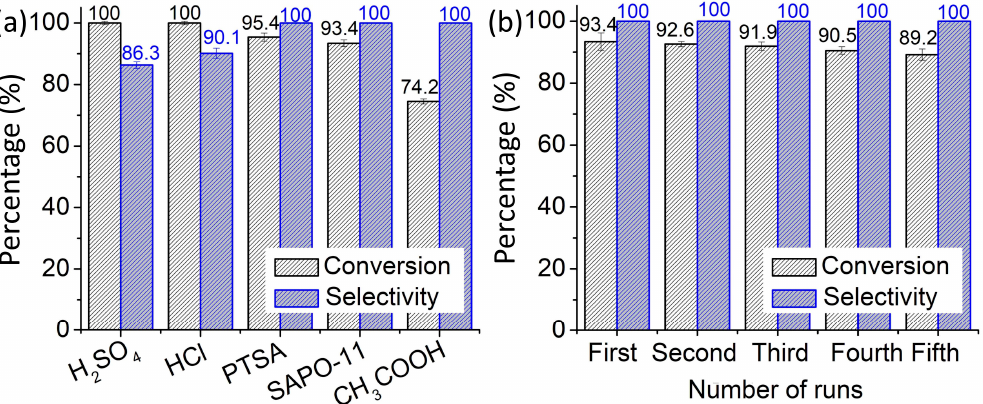
12 of 18 Figure 10. ( A ) Conversion of levulinic acid via esterification enhanced by SAPO-11 (E-3) catalyst at ( a ) 150 °C, ( b ) 160 °C, ( c ) 170 °C and ( d ) 180 °C under conductive instant heating using reaction conditions: m SAPO-11 = 0.100 g, levulinic acid:ethanol ratio = 1:11, and ( B ) effect of catalyst loading on the conversion of levulinic acid using reaction conditions: temperature = 180 °C, time = 30 min, le- vulinic acid:ethanol ratio = 1:11. The esterification reaction was also investigated at various temperatures (150 ‒ 180 °C) from 0 to 60 min. The reaction conversion is enhanced by increasing the heating tempera- ture, as shown in Figure 10A. This is due to the fact that when more energy is provided to the system, the reaction rate increases, as stated by the Arrhenius equation [55]. For in- stance, at 30 min of reaction, 82.6% of conversion is recorded at 150 °C, and this increases to 87.0% (160 °C) and 90.6% (170 °C) before reaching 93.4% at 180 °C (Figure 10A(a–d)). Based on the reaction study, the optimum reaction time and temperature are 30 min of heating at 180 °C, because the conversion rate nearly plateaus after 30 min. The effect of catalyst amount was also studied at 180 °C for 30 min with a molar ratio of 1:11 (levulinic acid:ethanol) using 0–0.125 g of SAPO-11. Without catalyst, the conver- sion rate is merely 6.6%, and the levulinic acid conversion rate rises significantly to 52.7% when 0.025 g catalyst is added (Figure 10B). The conversion rate keeps increasing to 93.4% with the catalyst load increased to 0.100 g. Such a phenomenon can be explained by the high availability of Brønsted acid sites when more solid acid catalyst is added, resulting in a high reaction conversion. However, the levulinic acid conversion slightly decreases when the catalyst loading is further increased to 0.125 g (91.7%), which may be due to the excessive catalyst loading causing inefficient stirring [56]. Furthermore, the water mole- cules produced during the esterification reaction can also deactivate the SAPO-11 cata- lyst’s active sites, and this compromises the effectiveness of the catalyst [57]. Therefore, 0.100 g of SAPO-11 catalyst is the ideal loading. The catalytic performance of SAPO-11 is also compared with conventional homoge- neous catalysts (H 2 SO 4 , HCl, acetic acid, p -toluenesulfonic acid) at 180 °C for 30 min of instant heating (Figure 11a). It is shown that both H 2 SO 4 and HCl achieve 100% conver- sion, but their selectivity towards ethyl levulinate are merely 86.3% and 90.1%, respec- tively; 4-ethoxy γ -valerolactone and alpha-Angelica lactone were produced as by-prod- ucts in both catalyzed reactions. For acetic acid, a low conversion rate (74.2%) with 100% selectivity of ethyl levulinate are recorded; this can be explained by its weak acidity. On